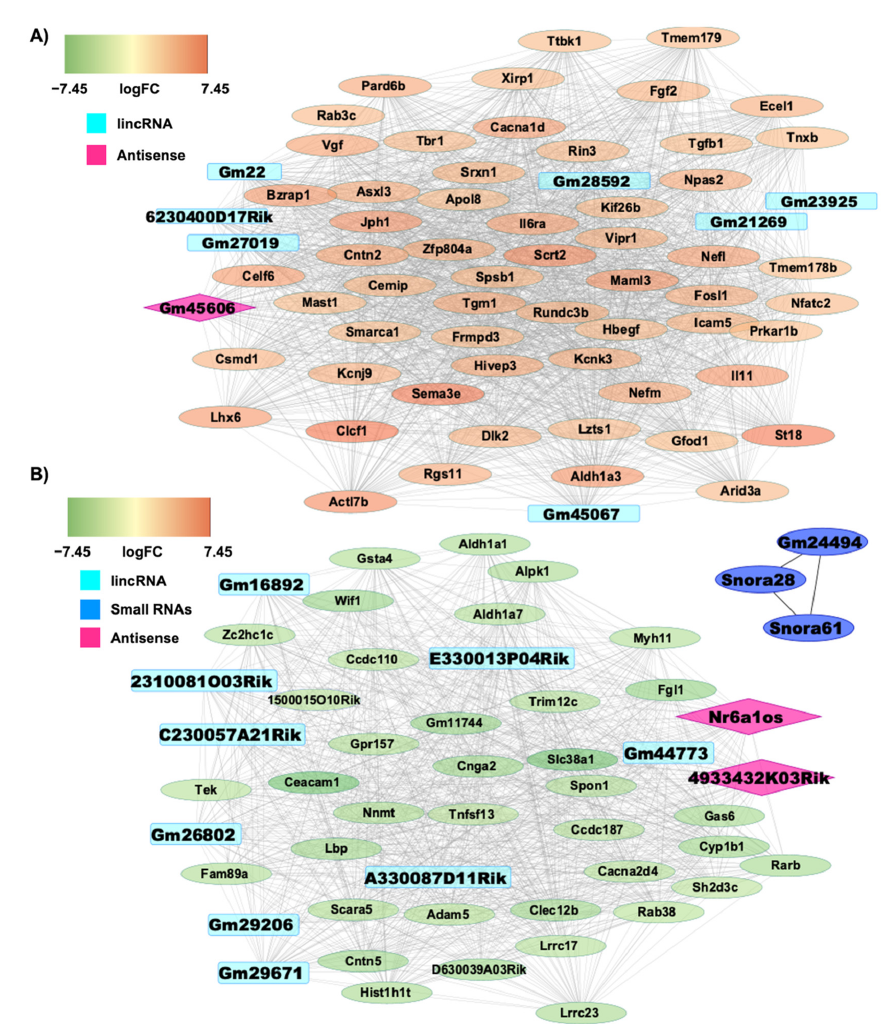
Figure 3. Study of investigated ncRNAs networks. On the basis of the turquoise and blue gene modules, two networks were constructed via Cytoscape. Both networks display coding genes represented in green or orange according to |log 2 FC|, lincRNAs light blue, antisense RNAs in pink, snoRNAs in dark blue. ( A ) The first network was obtained from the turquoise module. Here, 7 lincRNAs and 1 antisense, highlighted respectively in light blue and in pink, interact with each other and with 58 coding genes. All coding genes involved in this interaction are up-regulated and are thus represented in orange according to their fold change. ( B ) The second network was obtained from the blue module. Here, 9 lincRNAs, represented in light blue, and 2 antisense, represented in pink, interact with each other and with 37 coding genes. All coding genes involved in the interaction are down-regulated and are thus represented in green according to their fold change. Moreover, with respect to small ncRNAs, represented in dark blue, Snora28 co-interacts with Gm24494 and Snora61 in a smaller network, forming a non-coding only network.